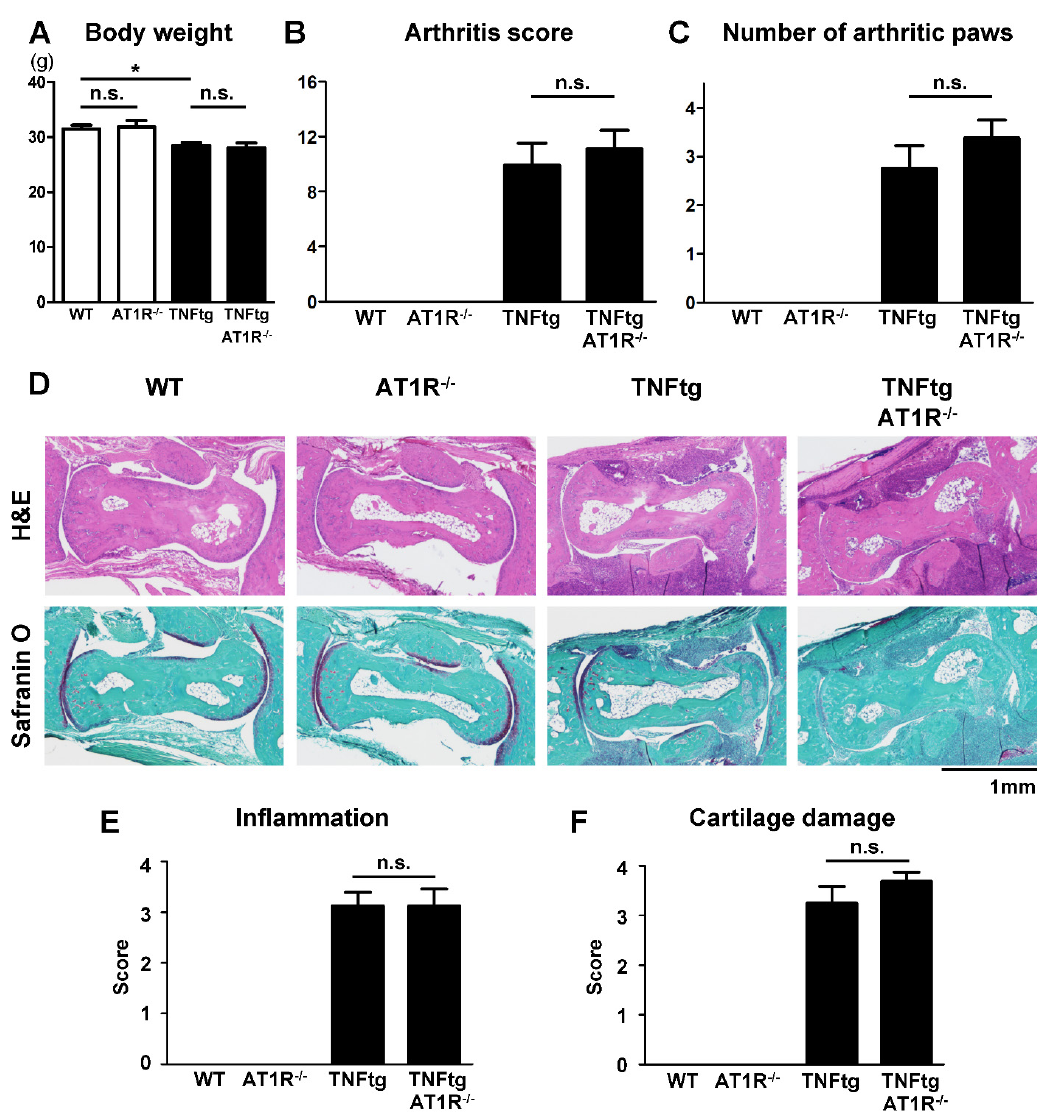
Figure 4. E ff ect of angiotensin II type 1 receptor (AT1R) deficiency on the severity of